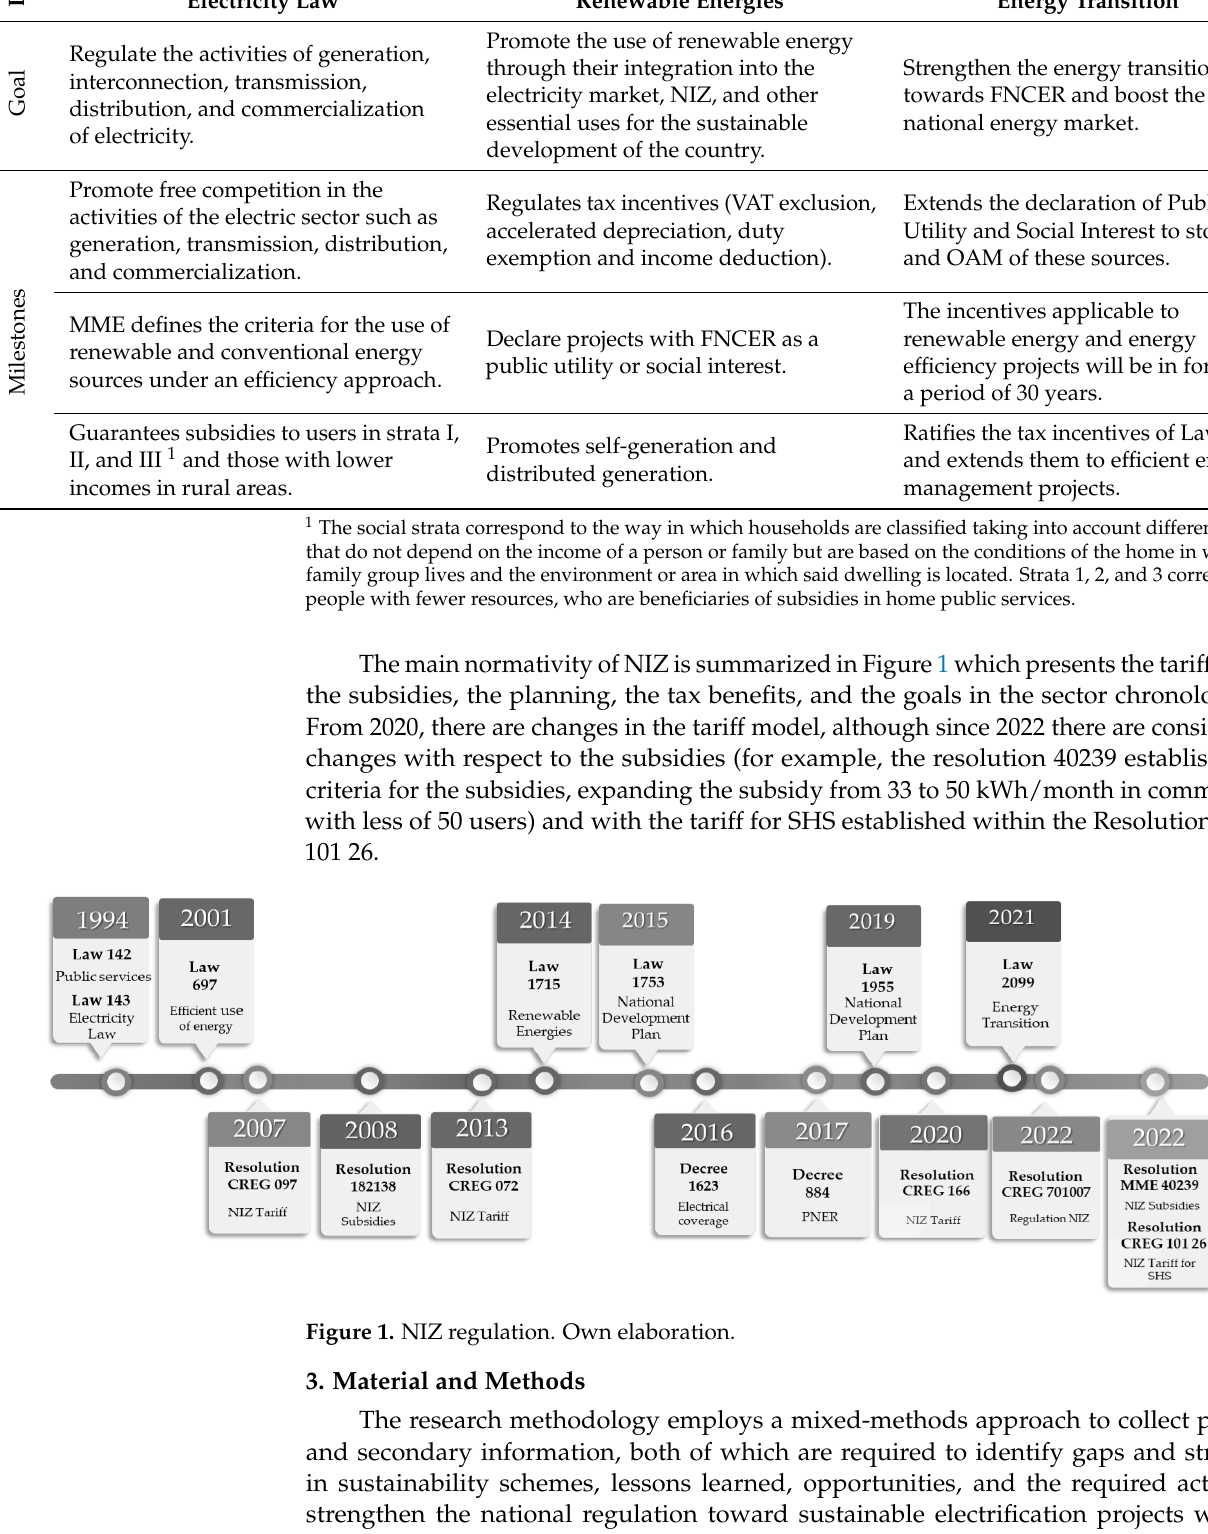
Table 1. Electricity sector laws: summary.